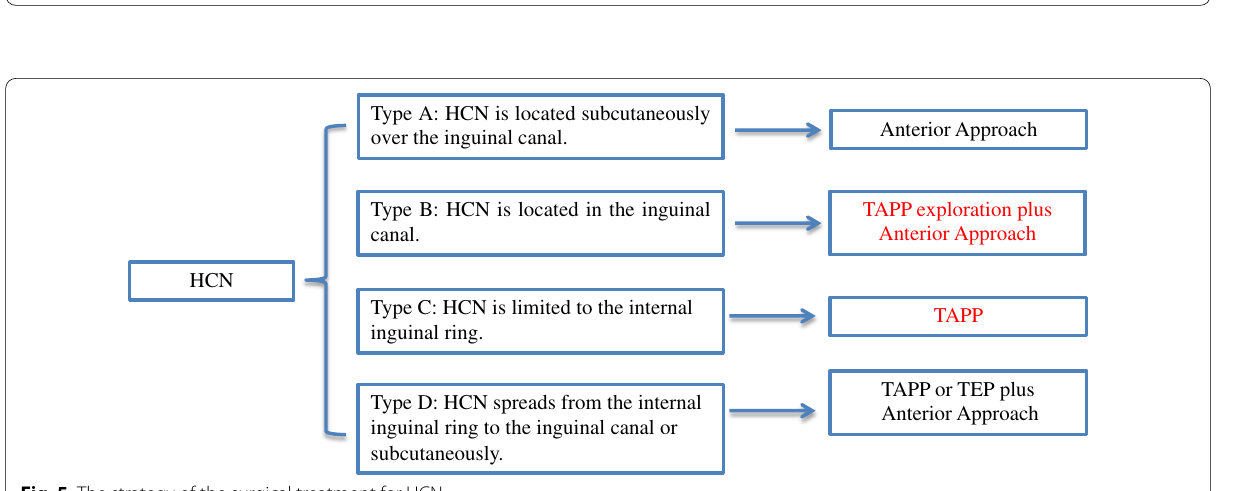
Fig. 4 HCN classifications. a Type A: HCN is located subcutaneously over the inguinal canal. b Type B: HCN is located in the inguinal canal. c Type C: HCN is limited to the internal inguinal ring. d Type D: HCN spreads from the internal inguinal ring to the inguinal canal or subcutaneously